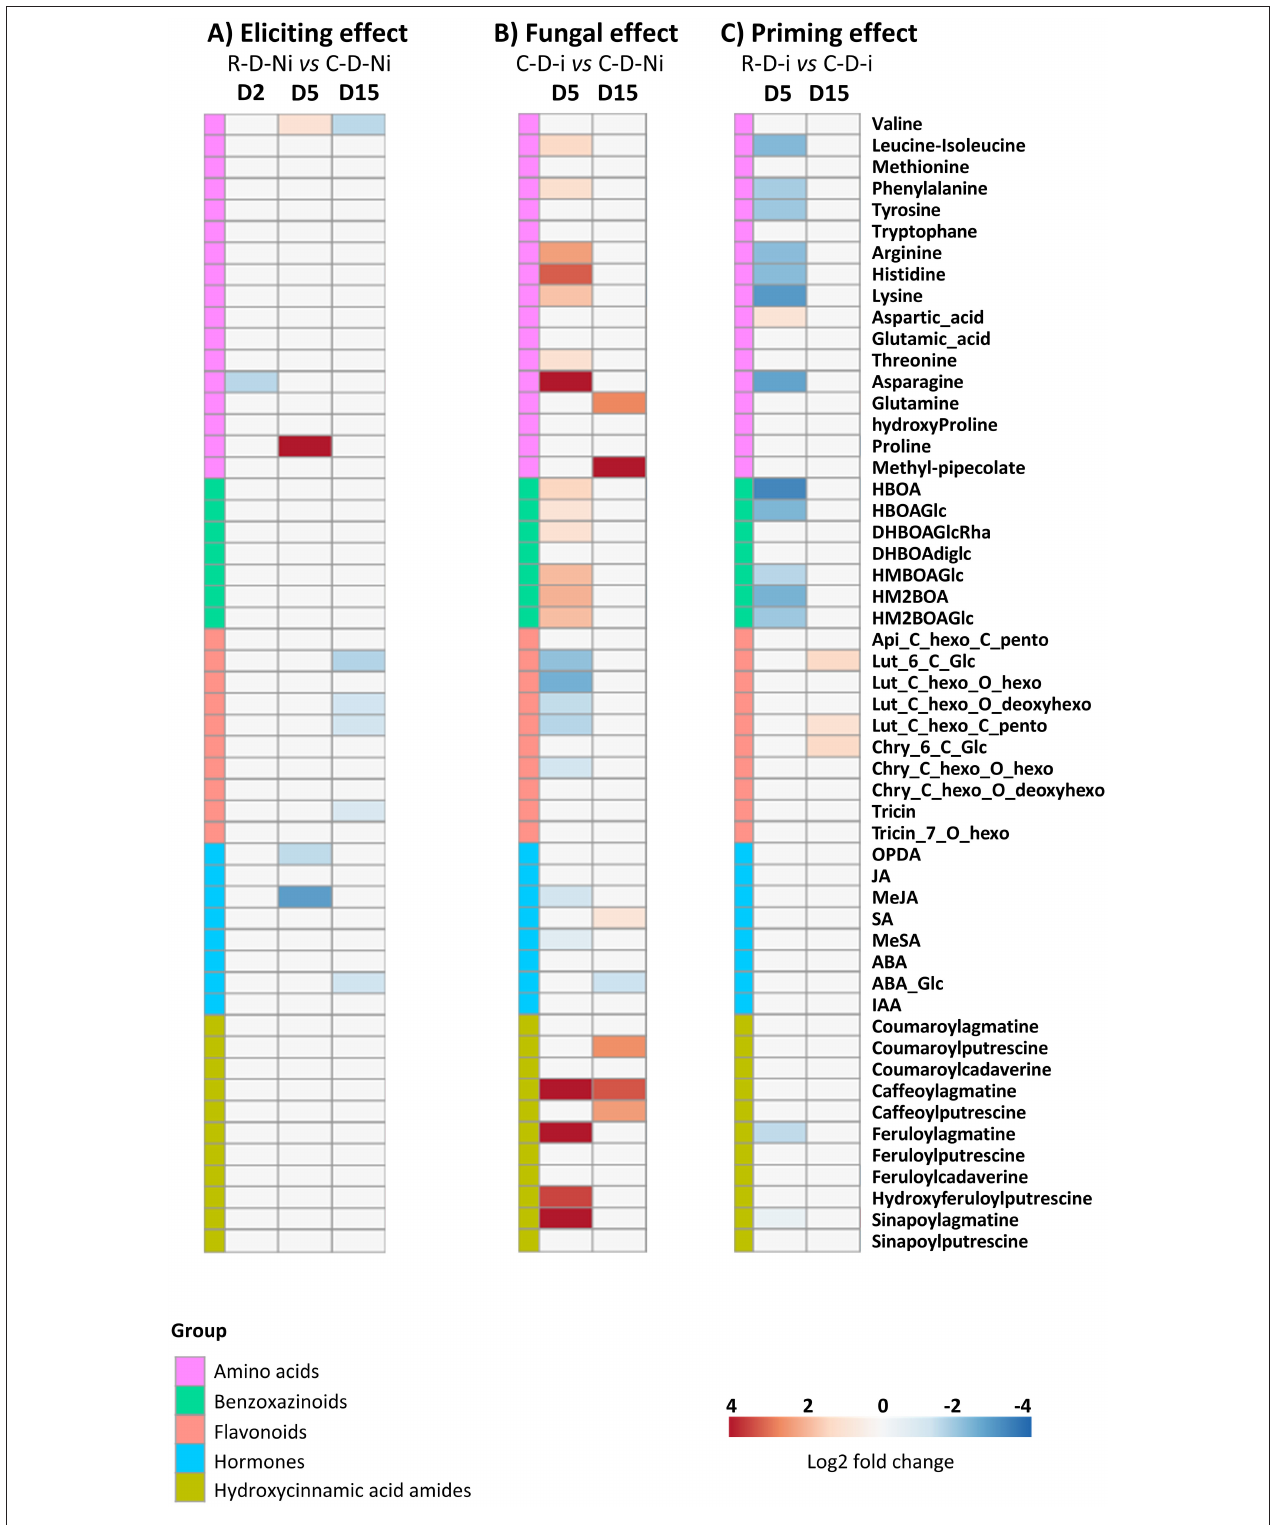
FIGURE 6 | Heatmap representation of differentially accumulated metabolites in wheat third leaves (Cv. Alixan) treated or not with Rh-Est-C12 and infected or not with Z. tritici (T02596 strain) at different time points. With metabolite relative accumulation changes in the (A) eliciting modalities, from left to right, R-D2-Ni vs.